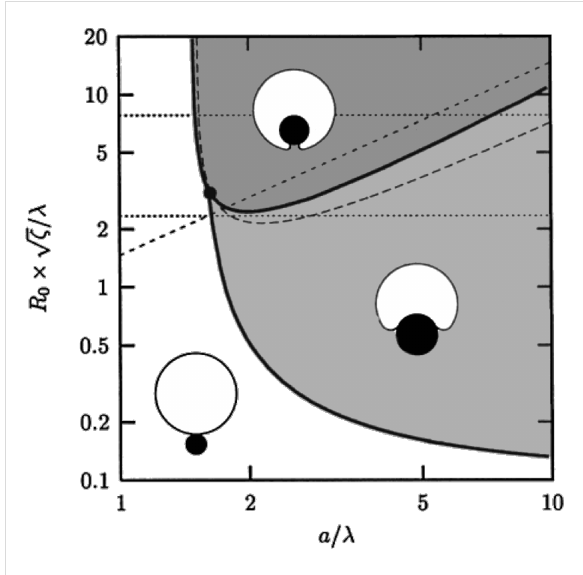
Figure 2: Phase diagram describing the interaction of particles with a spherical vesicle with initially zero tension. The parameters are here defined as follows: R 0 denotes the initial vesicle radius; a corresponds to the particle radius r ; ; ζ = g ad / g ten . In short, very small particles will not be wrapped at all due to the bending resistance (white). The wrapping of big particles is rather limited by membrane tension (light grey). Only for low vesicle tension and sufficiently big particles full wrapping is possible (dark grey). Reprinted with permis- sion from [21]. Copyright 2002 American Chemical